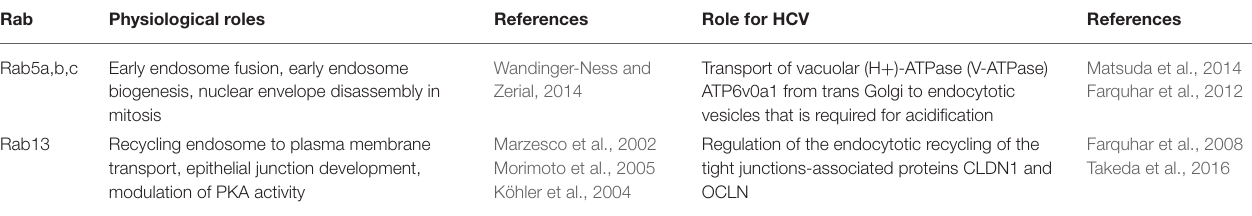
TABLE 1 | Rab proteins involved in HCV